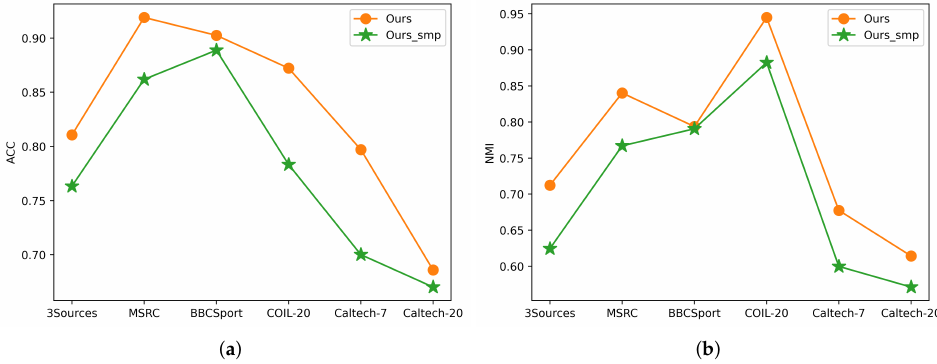
Figure 5. Auto-weight learning strategy (adopted in Our original model) vs. average weighting strategy (denoted by Ours_smp ). ( a ) ACC. ( b )